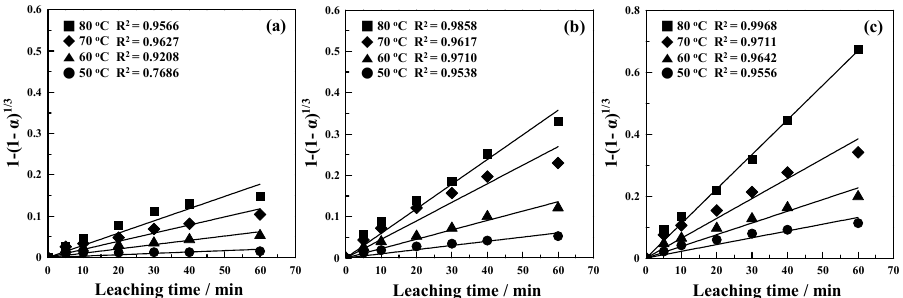
Figure 5. Plots of [1 − (1 − α ) 1/3 ] versus time at various leaching temperature for ( a ) the as-received CuS; ( b ) the CuS ground at 300 rpm for 15 min; and ( c ) the CuS ground at 700 rpm for 15